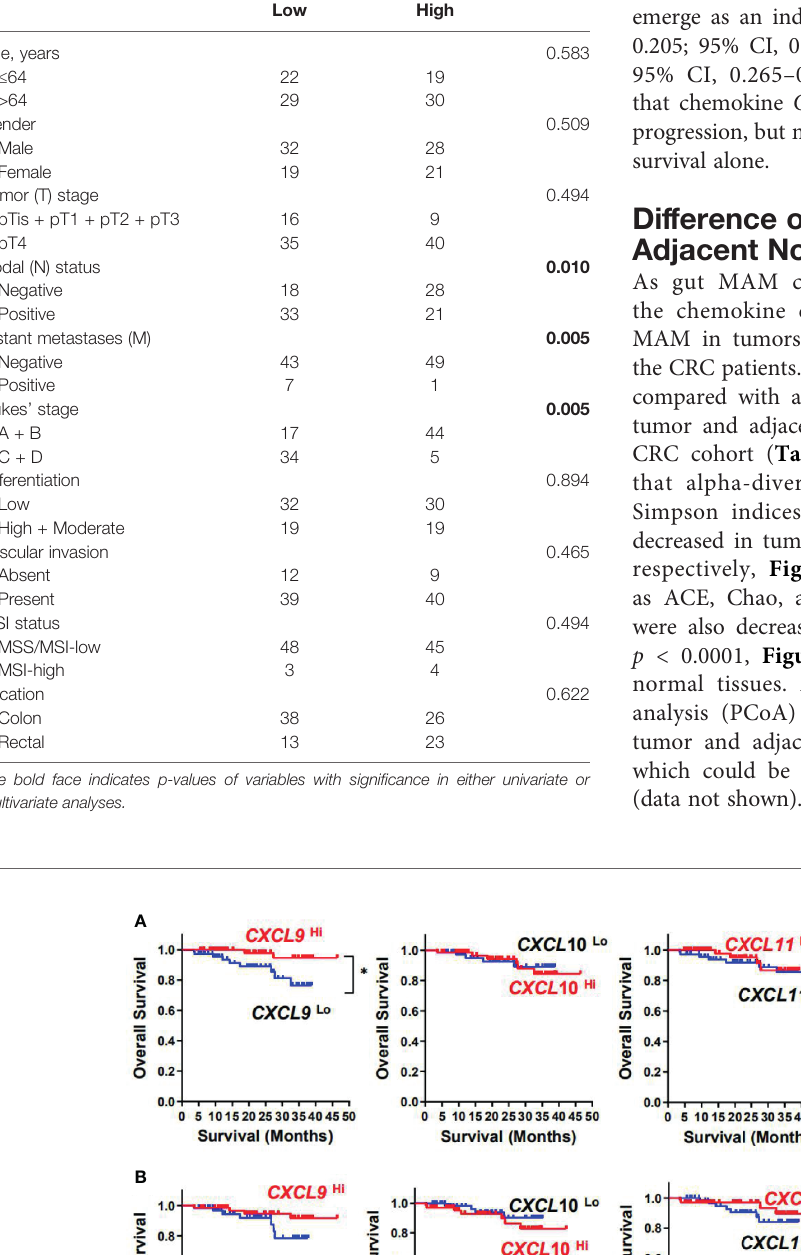
TABLE 1 | Association of CXCL9 mRNA expression levels in tumor with clinicopathologic characteristics. Variables